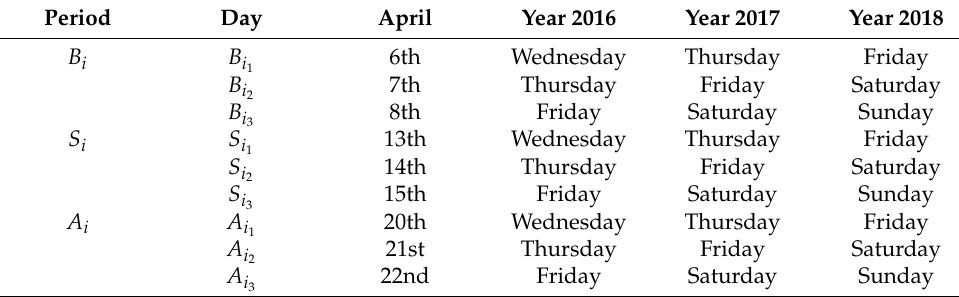
Table 5. The weekday for each period in